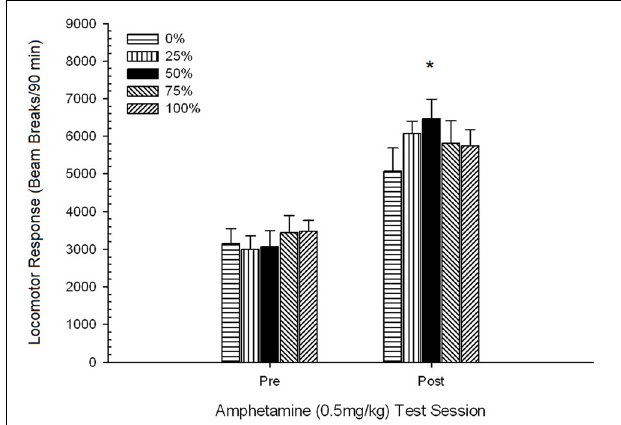
FIGURE 9 | Mean (SE) locomotor response (number of beam breaks in an electronic array per 90min) to 0.5mg/kg d-amphetamine on separate sessions before and after a 5-session sensitizing regimen of d-amphetamine (1.0mg/kg; i.p. per session) in groups of Lewis rats ( n = 8/group) previously exposed to 15 daily conditioning sessions with sucrose reward (10% solution) delivered under 0, 25, 50, 75, or 100% variable schedules. The conditioned stimulus was a light (120s). Group 0 received the same number of rewards as group 100 in the absence of conditioned stimuli. ∗ p < 0 . 05 for mean difference between group 50 and group 0 as well as group 100, based on planned comparisons.